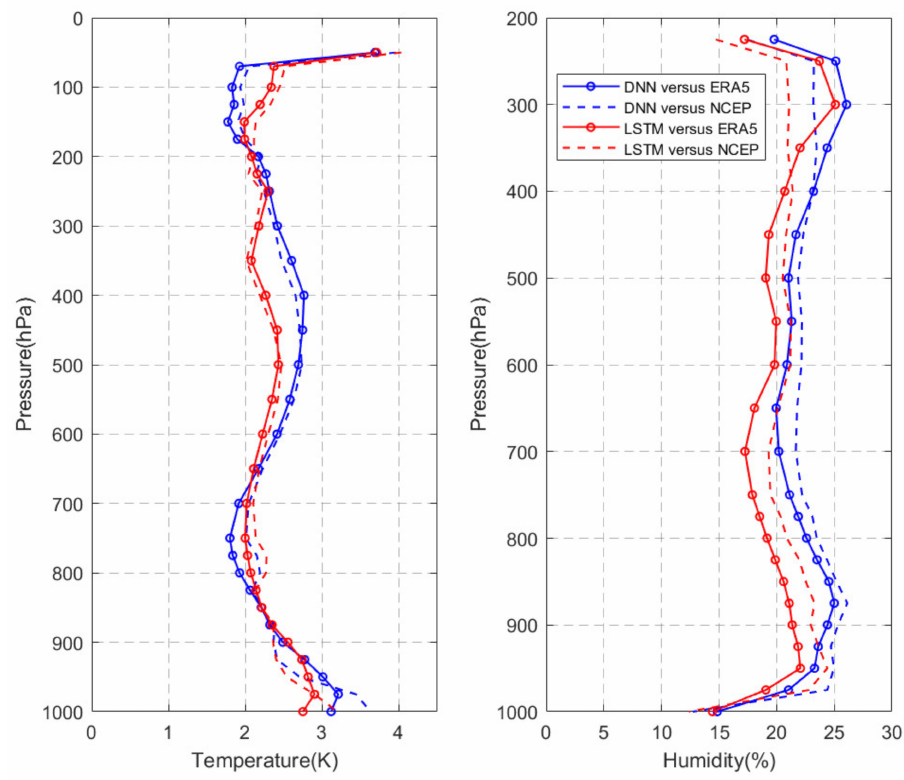
Figure A5. The retrieval RMSEs of the DNN model and the LSTM model with respect to ERA5 and NCEP reanalysis data over mixed ice–water in April 2021.